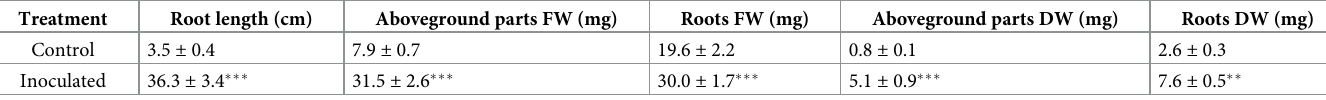
Table 2. Seedling growth in the inoculation